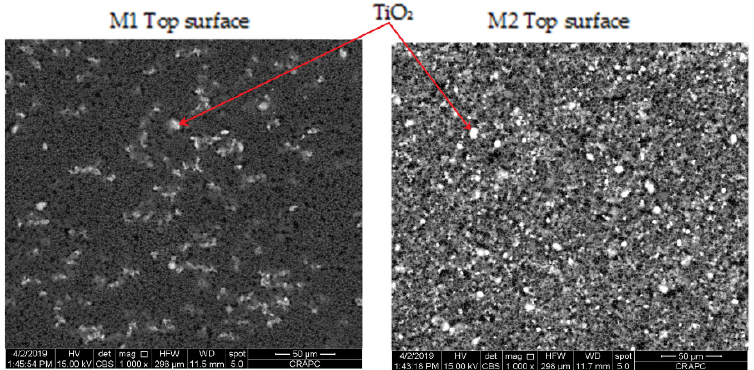
Figure 2. Top surface of membranes M1 and M2 collected on the concentric backscatter (CBS) detector from the FEI company.